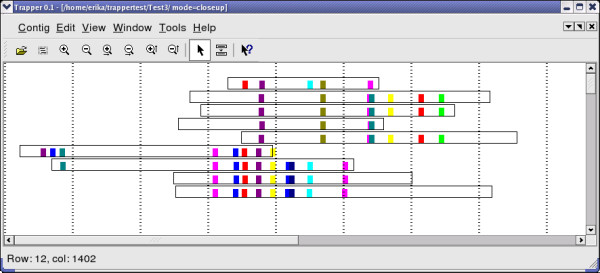
Zoomed in view of an erroneous merging of two repeat groups by the DNP sorting algorithm. The error is caused by two sequencing errors in the read at the top, where two bases (first red and third cyan) have been erroneously sequenced into DNP bases of another group.